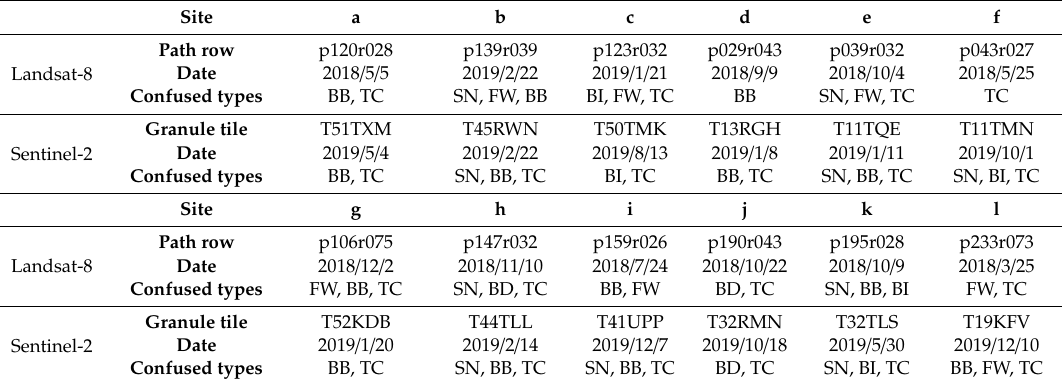
Table 1. Details of the Landsat-8 and Sentinel-2 image scenes from the di ff erent test sites.